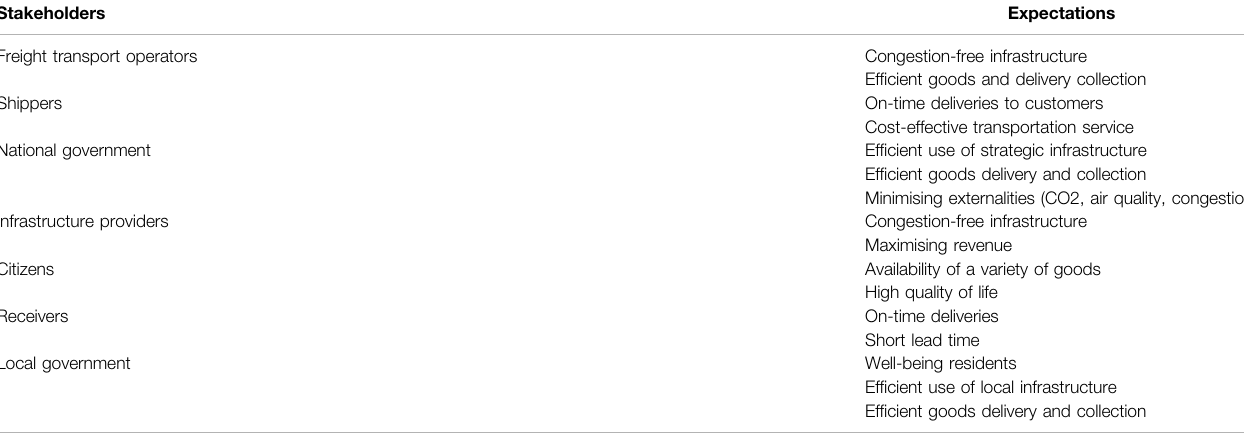
TABLE 2 | Freight transport stakeholders and expectations (Government Of fi ce for Science,